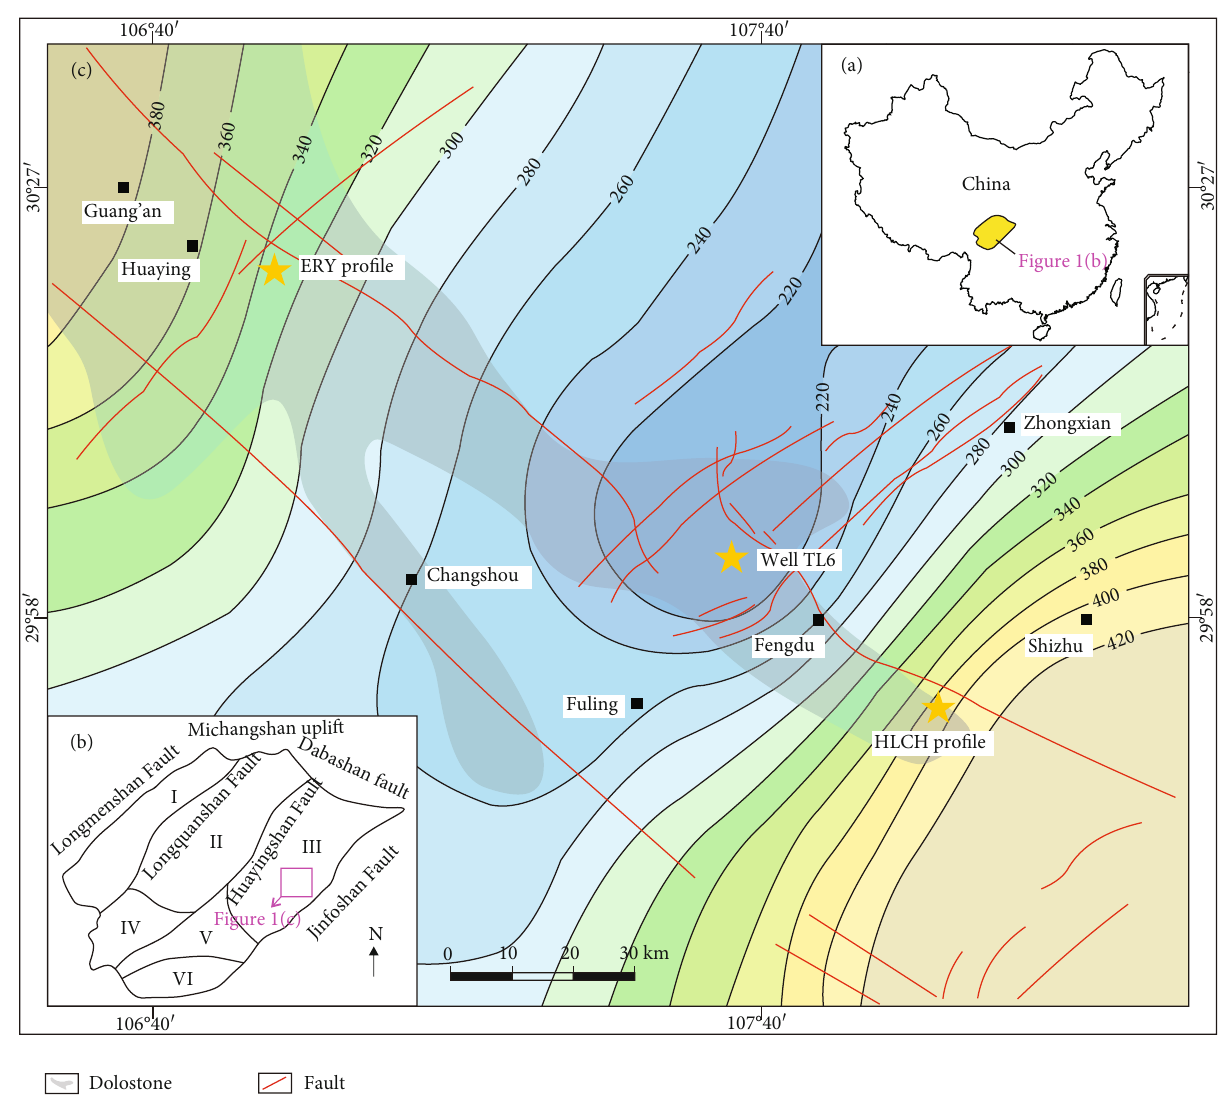
Figure 1: (a) Location of the Sichuan Basin in Chinese territory. (b) Geographic location of the study area in Eastern Sichuan. (c) Locations of sampling pro fi les [34]. I — structural zone in Western Sichuan; II — structural zone in Central Sichuan; III — structural zone in Eastern Sichuan; IV — structural zone in Southwestern Sichuan; V — structural zone in Southern Sichuan; VI — structural area of